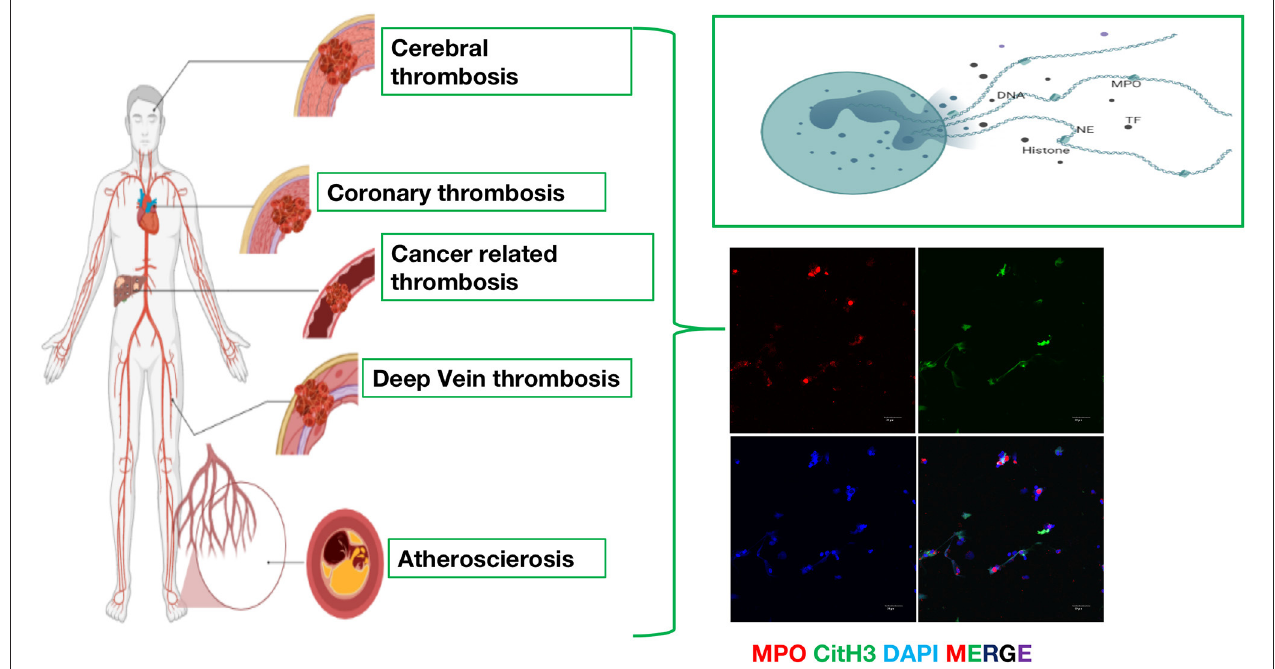
FIGURE 1 | The emerging role of neutrophil extracellular traps (NETs) in arterial thrombosis, venous thrombosis and cancer-related thrombosis. Immunofluorescence of NETs. Red: MPO, Green: CitH3, Blue: